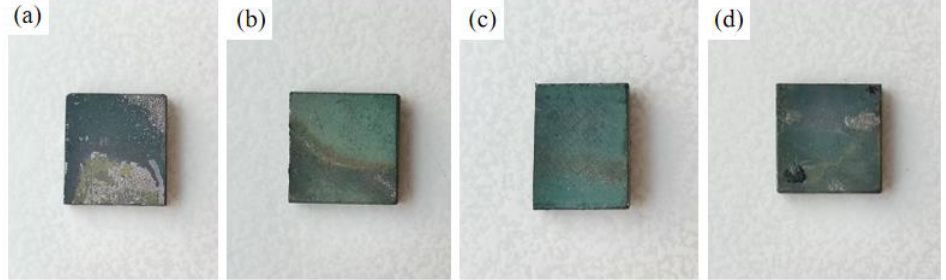
Figure 8. Macroscopic morphologies of coatings under different pre-oxidation temperatures at 1000 ◦ C for 300 h: ( a ) untreated; ( b ) 900 ◦ C; ( c ) 950 ◦ C; ( d ) 1000 ◦ C.